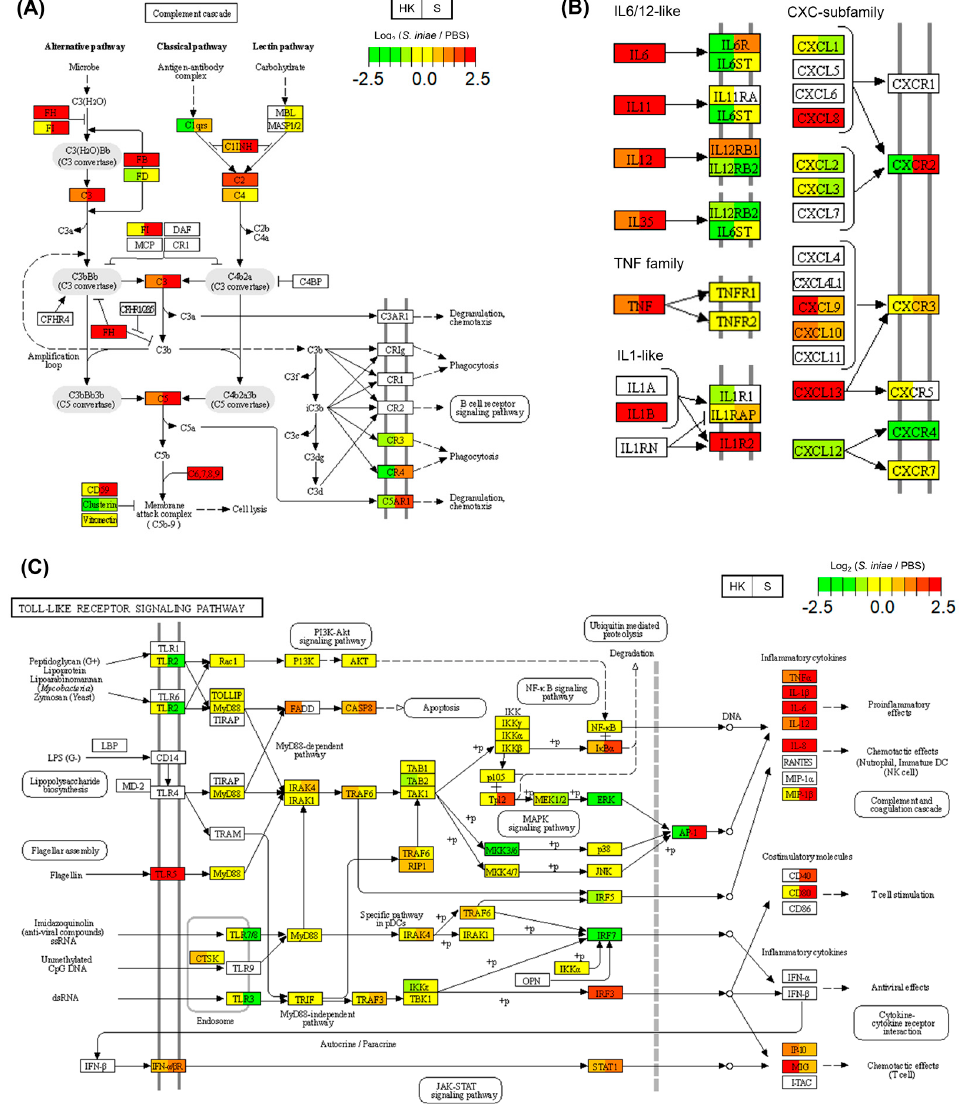
Figure 5. Pathway maps enriched by common differentially expressed genes (DEGs) between the head kidney and spleen after Streptococcus iniae infection. Relative gene expression levels in the S. iniae -infected and phosphate-buffered saline (PBS)-treated groups are shown in these visuals of complement and coagulation cascades ( A ), cytokine–cytokine receptor interactions ( B ), and Toll-like receptor signaling ( C ). The gene expression levels for the two groups, head kidney (HK) and spleen (S), are shown in each gene box. The lower expression levels of genes are shown in green, and the higher expression levels of genes are shown in red. Undetected genes are shown in white (see color legend in figure).